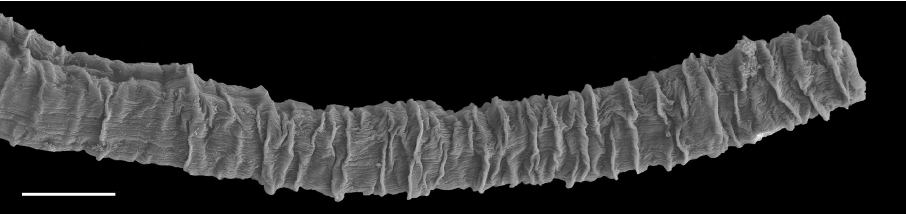
Figure 28. Penis, distal part free in the vestibule, Wallaconchis gracile , Indonesia, Bali, scale bar 40 μm [3106] (UMIZ